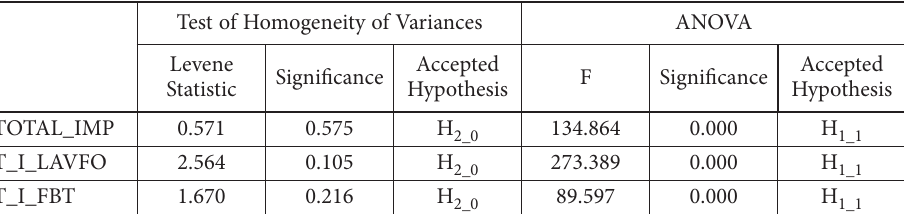
Table 2. The results of testing the statistical significance of Romania’s import volumes average values in the year 2007, at EU states group level (source: authors’ own computations)